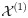
MV-ERM.(A) ERM for single-view learning. It demonstrates a general single-view learning algorithm (based on ERM estimator) that takes one data set X(1) as input, adopts a hypothesis space F(1) and a loss function l, and outputs a function f(1)∈F(1) that predicts the label associated with any new datapoint x as f(1)(x). (B) MV-ERM demonstrates a general multiview learning algorithm (based on MV-ERM estimator) that takes v datasets X(1),…,X(v) as v views, adopts v hypothesis spaces F(1),…,F(v) associated with v views, and outputs v functions (f(1),…,f(v))∈F(1)×…×F(v) that reveals the interactions within and between each pair of datasets (via the terms Ωco(f(i),f(j)). The consensus and complementary principles are implemented by the term Ω(f(i)) and Ωco(f(i),f(j)) respectively. Note that in MV-ERM estimator, the loss function is optional because multiview learning can be unsupervised. ERM, empirical risk minimization; MV-ERM, multiview empirical risk minimization.